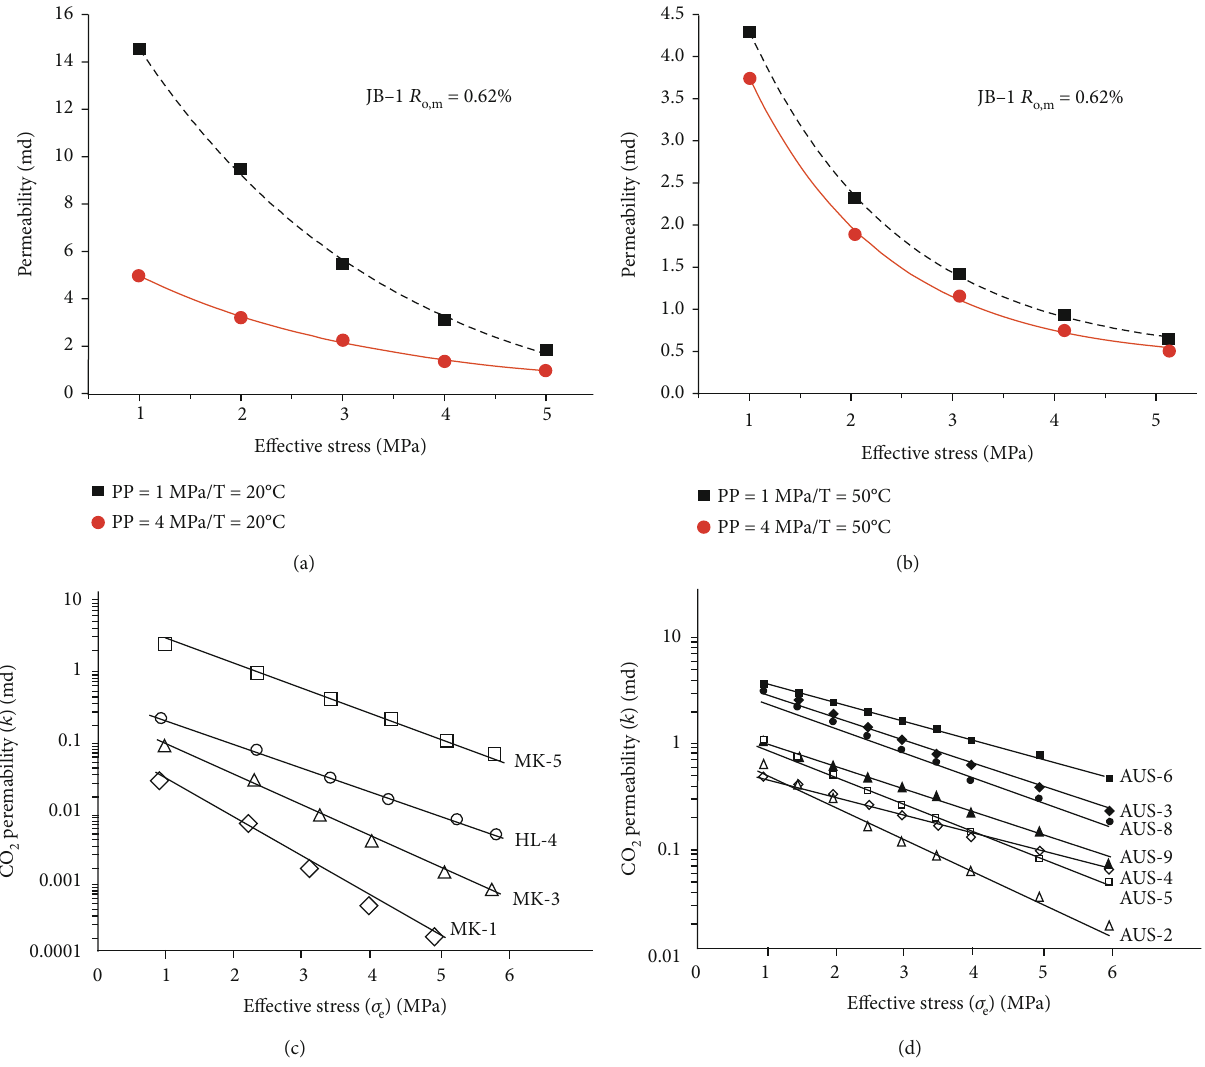
Figure 22: Relationship between coal permeability and e ff ective stress (modi fi ed from Cai et al. [120] and Mckee et al.